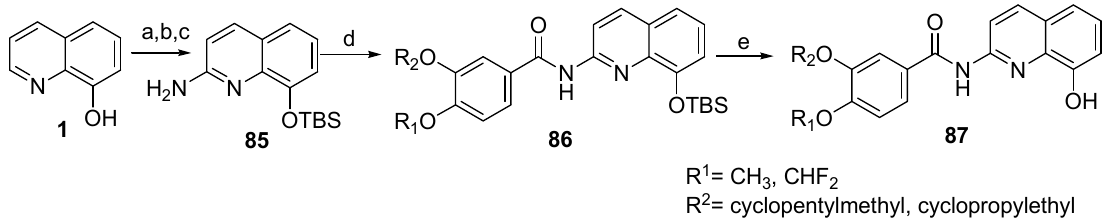
Scheme 20. Synthesis of new derivatives of 84 . Reagents: ( a ) benzyl bromide, K 2 CO 3 ; ( b ) SeO 2 ; ( c ) NaClO 2 , NaH 2 PO 4 ; ( d ) (i) SOCl 2 ; (ii) 3-(cyclopentyloxy)-4-methoxyaniline or 3,4-dimethoxyaniline, TEA; ( e ) H 2 , Pd/C.